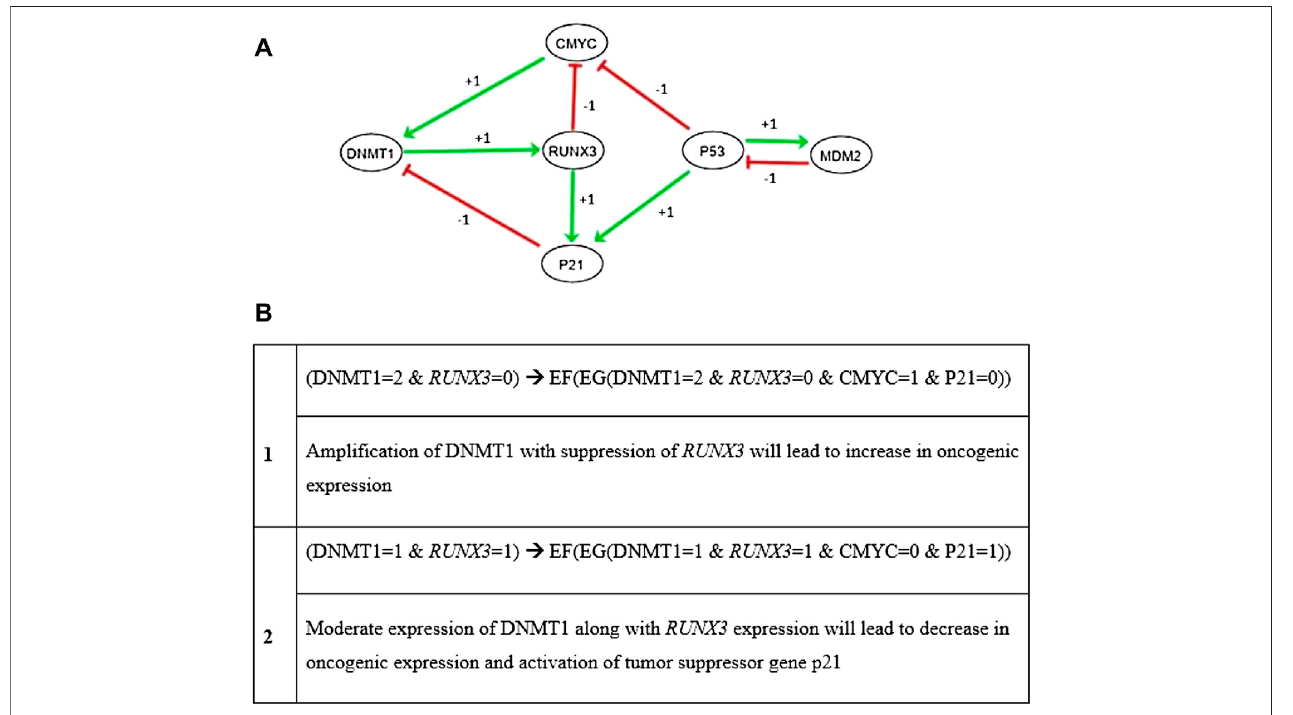
FIGURE3|(A) DNMT1 – RUNX3 interactiongraph(BRN)wasgeneratedbyutilizingthepreferredentitiestodiscoveralltheimportantactivation(+)andinhibition( − ) relationships among them. The network demonstrates predominantly two oscillatory behaviorsin DNMT1 – RUNX3 graph. The fi rst one illustrates the RUNX3 -stimulated onsetofp21,whichinturnpositivelyregulatesDNMT1(shownwithredarrows).Theotherloopexhibitstheinhibitionofc-mycby RUNX3 ,whichalsoinstigatestheonset of DNMT1 (shown with green pointed arrows). In addition, p53 can also be seen regulating DNMT1 through the activation of p21 and inhibition of c-myc signals. (B) The second part of the fi gure demonstrates two CTL observations utilized by SMBioNet for the estimation of parameters that were later used to generate the state graph of the dynamic model. According to CTL formulas, the overexpression of DNMT1 is responsible for hypermethylation at the promoter region of RUNX3 and ultimately its suppression, which is associated with many cancer types including breast cancer. Each circle/node represents a gene, and the arrows among them show the type of interaction they hold. Activation is denoted with green pointed arrows, and blunt red arrows represent inhibition whereby the weight of the arrows depicts threshold values of